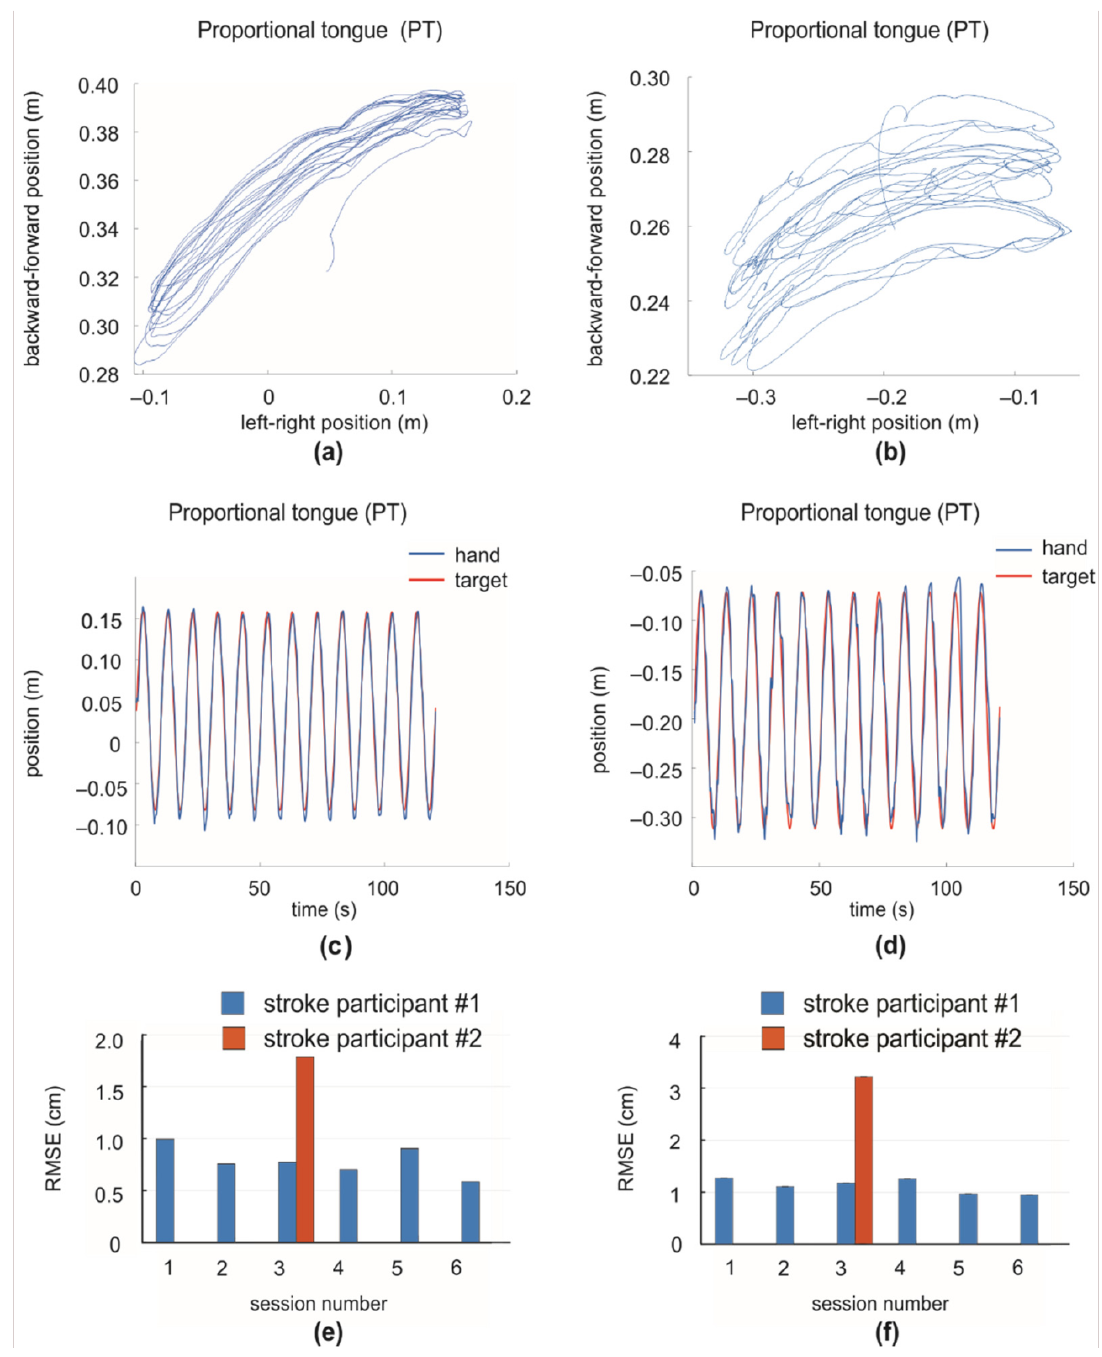
Figure 5. Tracking task performance of proportional tongue control (PT) for stroke participants. ( a , b ) Examples of hand displacements of stroke participants #1 and #2 during target tracking in the left-right directions using the proportional tongue control mode (PT); the mean speed of moving target is 5.3 cm/s. ( c , d ) The position of the affected hand and target as a function of time for stroke participants #1 and #2 during the target tracking using control mode (PT); the mean speed of the moving target is 5.3 cm/s. ( e , f ) The root mean square error (RMSE) for participants #1 and #2 during tracking a target in the left-right directions for 2 min in experimental sessions; the target speed is 5.3 cm/s in ( e ) and 8.0 cm/s in ( f ). Note that participant #2 performed this task only in session 3 (see Section 2 for